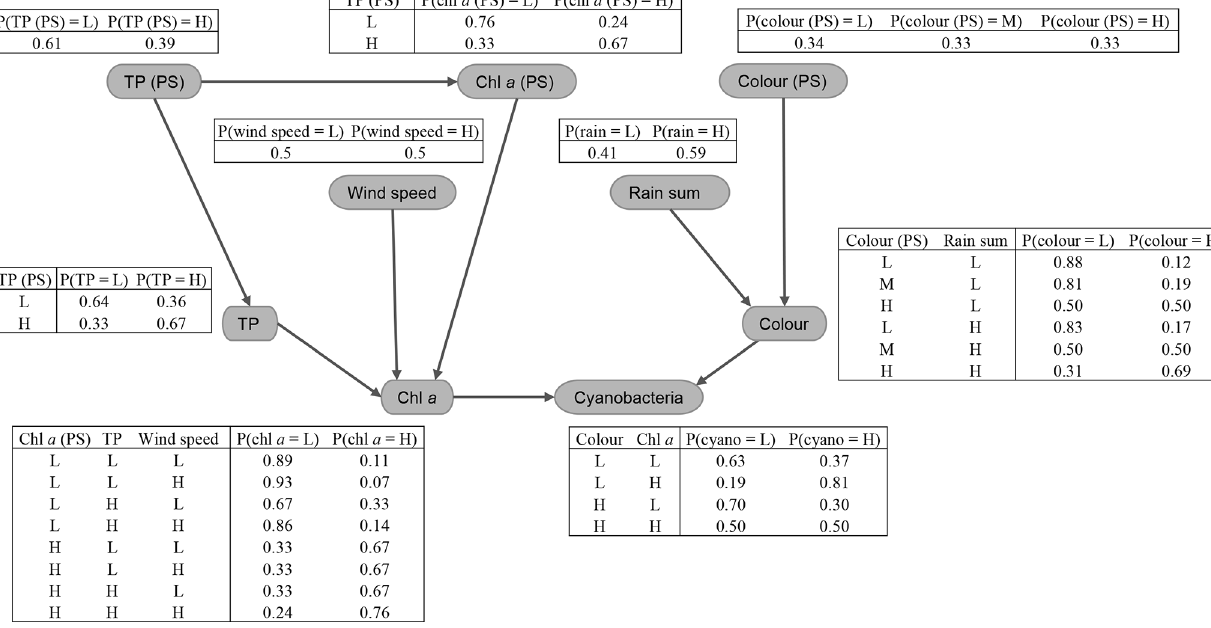
Figure 8. Fitted conditional probability tables for the discrete Bayesian network. Values were discretised into low ( L ) or high ( H ) classes – a medium ( M ) class was also included for colour (PS) – as described in Sect.